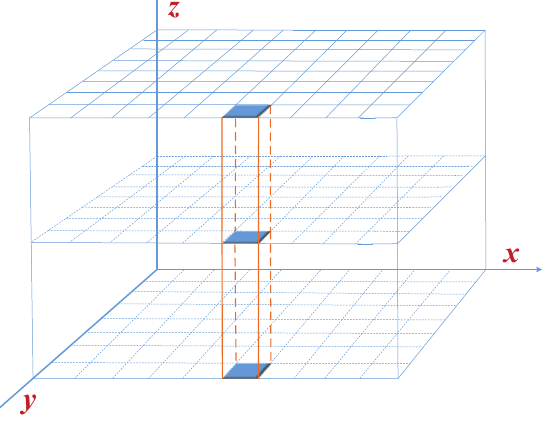
Figure 2. Spatial structure of RRTMG_LW.